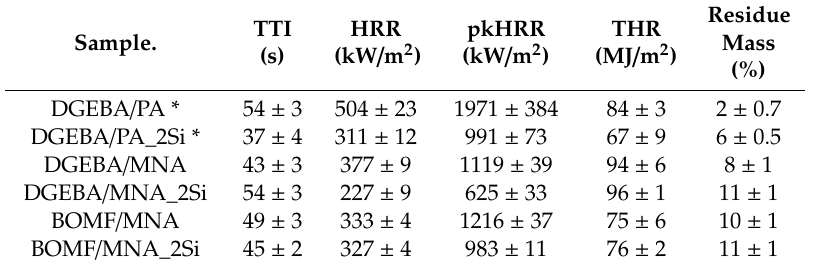
Table 5. Smoke results from cone calorimetry tests performed on epoxy resins and epoxy/silica hybrids. TSR, total smoke release; SEA, specific extinction area. Table 4. Results from cone calorimetry tests performed on epoxy resins and epoxy / silica hybrids. TTI, time to ignition; HRR, heat release rate; pkHRR, peak of the heat release rate; THR, total heat released.